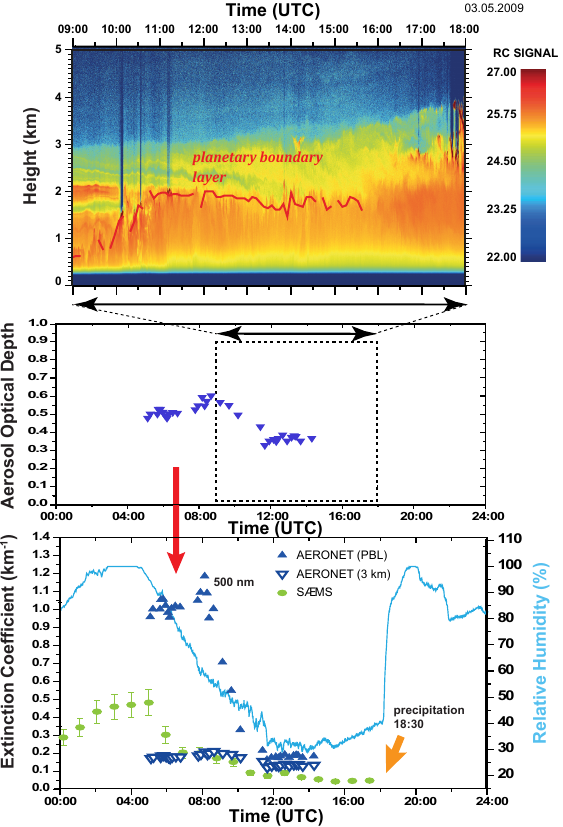
Fig. 5. (Top) Range-corrected 532nm backscatter signal measured with lidar on 3 May 2009. The lidar measurement shows the boundary layer (BL) with top height < 1km before 09:30UTC and from 1.7 to 2.0km between 12:00 and 16:00UTC. Free tro- pospheric aerosol layers reach to 3–4km height. (Center) Mea- sured aerosol optical depth (AOD, AERONET) at 500nm. (Bot- tom) SÆMS 550nm particle extinction coefficient (circles, at 30m height) and estimated vertical mean particle extinction coefficient for the boundary layer (filled blue triangles, ratio of AOD to PBL top) and for the entire 3km deep tropospheric aerosol layer (open blue triangles). The light-blue line shows the relative humidity mea- sured on the roof of the TROPOS building. At 18:30UTC a sharp increase in humidity indicates an air-mass change. Fig. 6. Four-day backward trajectories (HYSPLIT) arriving at